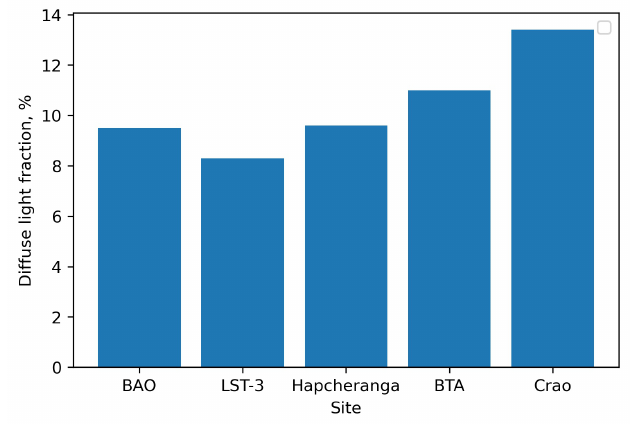
Figure 1. Diffuse light at astronomical observatories and sites suitable for